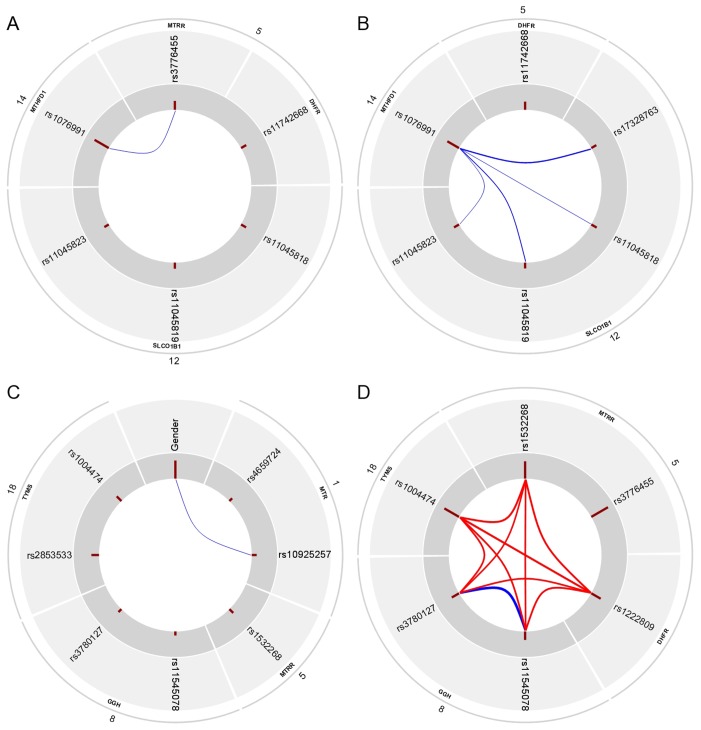
Redundancies and interactions according to the BN-BMLA method.The figure shows the magnitude of redundancies (blue curved lines) and interactions (red curved lines) between the variables in the overall (i.e. ALL susceptibility, A panel), in the B-cell lineage (B panel), in the T-cell lineage (C panel) and in the hyperdiploid patient group (D panel) according to the BN-BMLA method. The width of the curved lines is proportional to the strength of the effect. The a posteriori probability of the strong relevance of the variables is proportional to the length of the dark red columns next to the variable in the inner gray colored ring. The corresponding genes and chromosomes of the SNPs are shown on the outer ring.